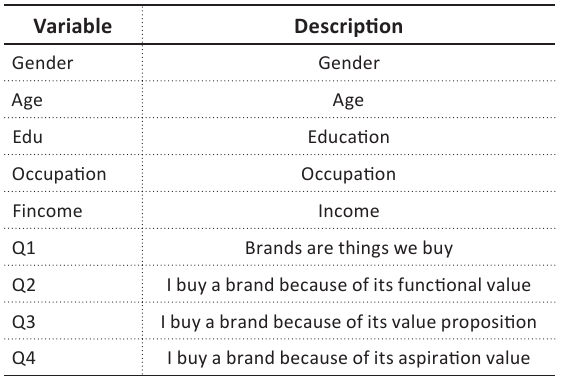
Figure 2. Distribution of variables by types Table 1. A snapshot of data dictionary